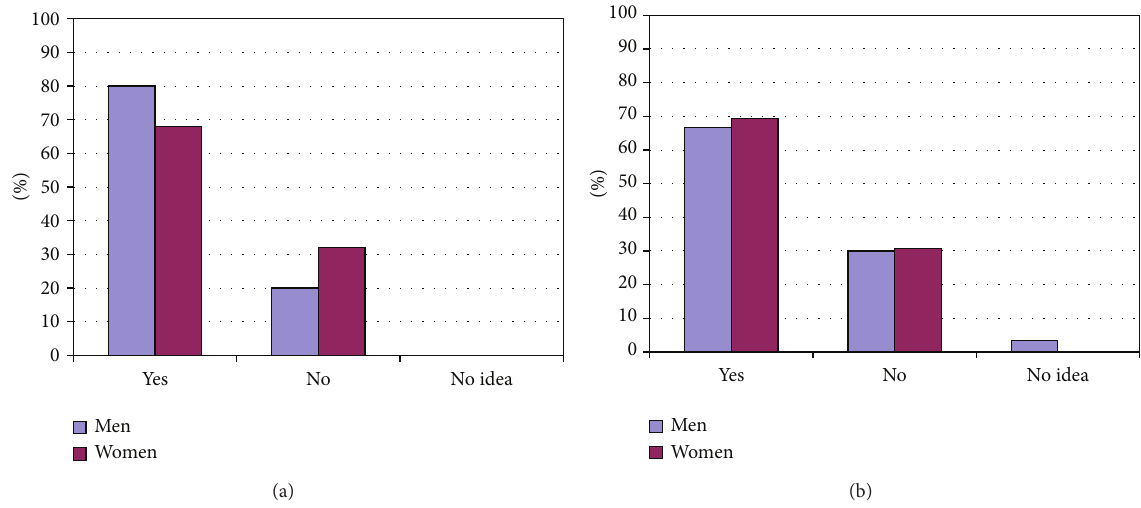
Figure 3: Users who use location-aware applications: DN (a) versus DI